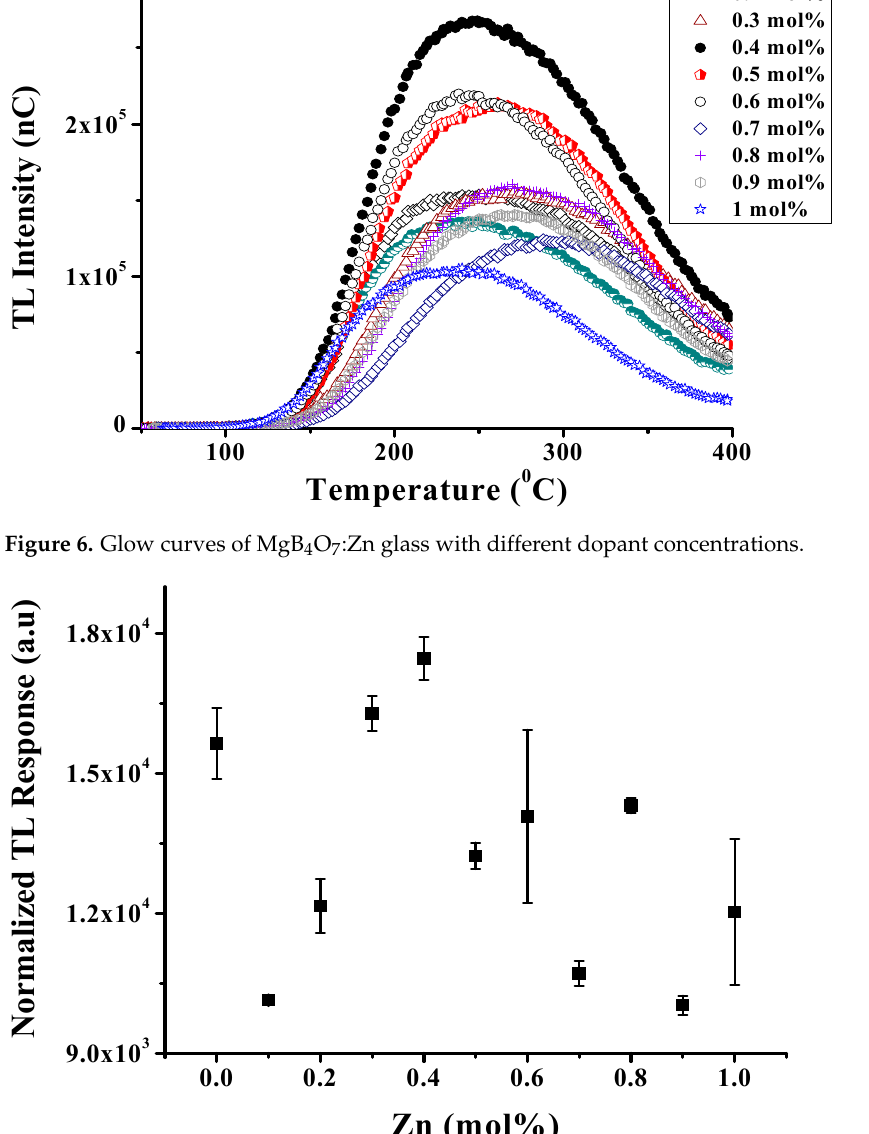
Figure 7. Effect of dopant concentration on TL response of MgB 4 O 7 :Zn glass.